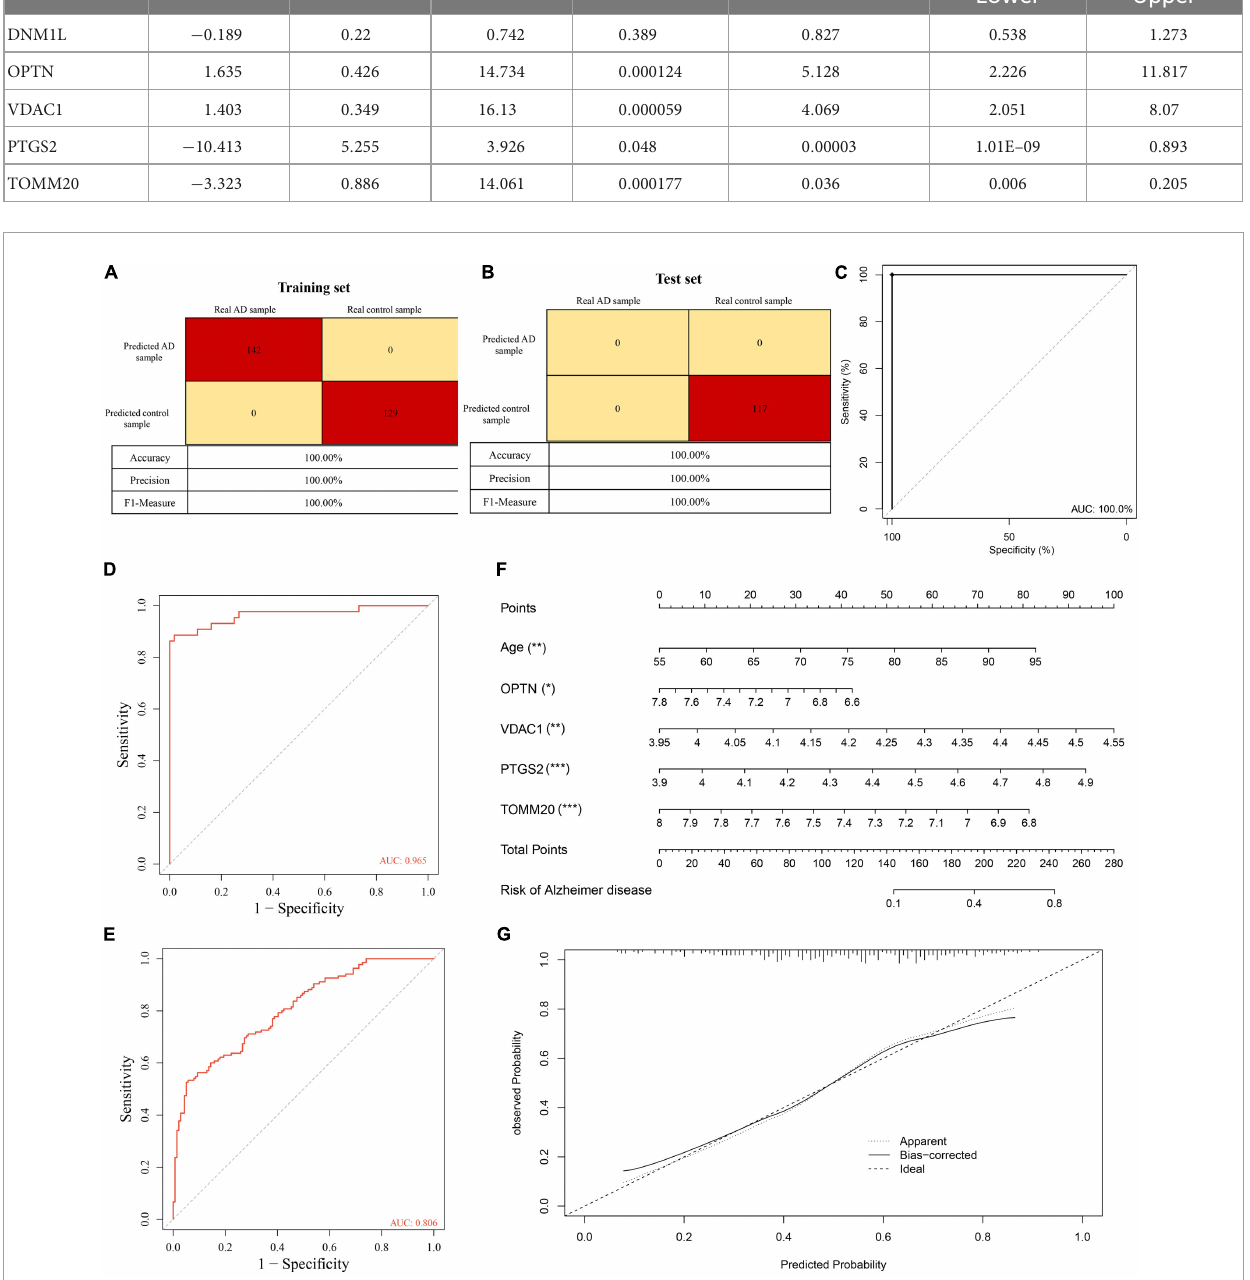
FIGURE6 (A) Confusion matrix heat map shows the classification results of training sets in GSE122063 by support vector machine (SVM) classification algorithm. (B) Confusion matrix heat map shows the classification results of test sets in GSE122063 by SVM classification algorithm. (C) The ROC curve verified the feasibility of the diagnosis of the SVM classification algorithm. (D,E) The ROC curve verified the feasibility of the diagnosis of the diagnostic prediction model. (F) Nomogram visual diagnostic prediction model. (G) Calibration curves verify the consistency of nomogram. *** p < 0.001, ** p < 0.01, * p <